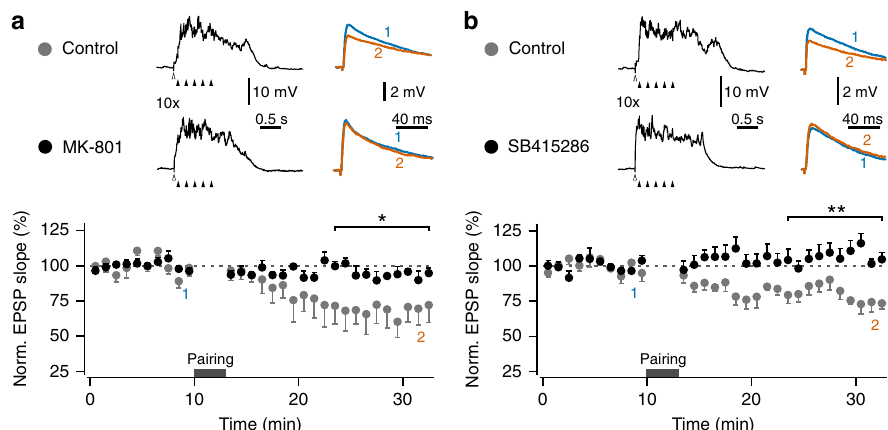
Fig. 6 Up state-induced synaptic weakening depends on postsynaptic NMDAR and GSK3 β . Single-cell pharmacology was used to explore the mechanisms of synaptic weakening induced by subthreshold Up state pairing, using extracellular stimulation protocols analogous to those in Fig. 1d (stimulus trains at 5 Hz; total of 50 individual EPSP pairings per recording). Both a intracellular blockade of NMDA receptors with MK-801 (200 μ M in internal solution, n = 6 vs. vehicle control, n = 5) and b inhibition of GSK3 β SB415286 (10 μ M in internal solution + 0.01% DMSO, n = 6 vs. vehicle control, n = 6), signi fi cantly reduced synaptic weakening. Top , middle : representative recordings during pairing protocols, showing the timings of Up state induction ( white arrowheads ) and the synaptic stimuli ( black arrowheads ). Top , right : representative average EPSP traces from the baseline period (1; blue ) and the end of recording (2; orange ) (average of fi ve traces). Bottom : pooled data of normalized single EPSP slope across experiments for each pairing protocol (1 min bins). ** P < 0.01, * P < 0.05, unpaired t -test. Error bars show the